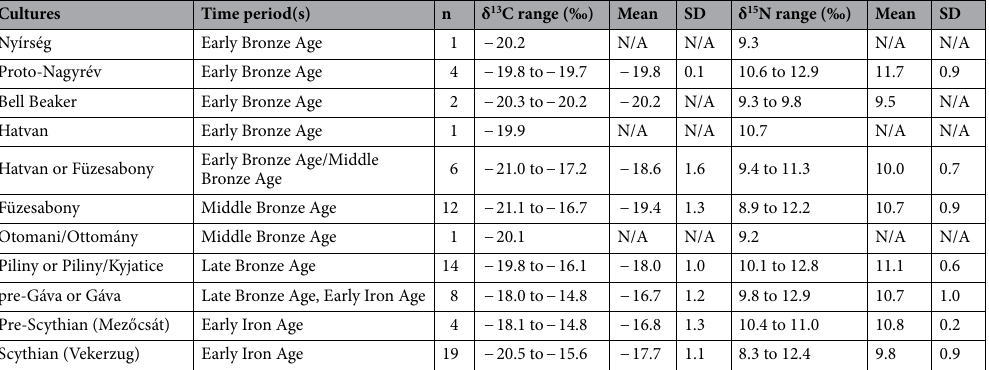
Table 3. Summary of human δ 13 C and δ 15 N results by culture with ‰ range, mean, and SD (±